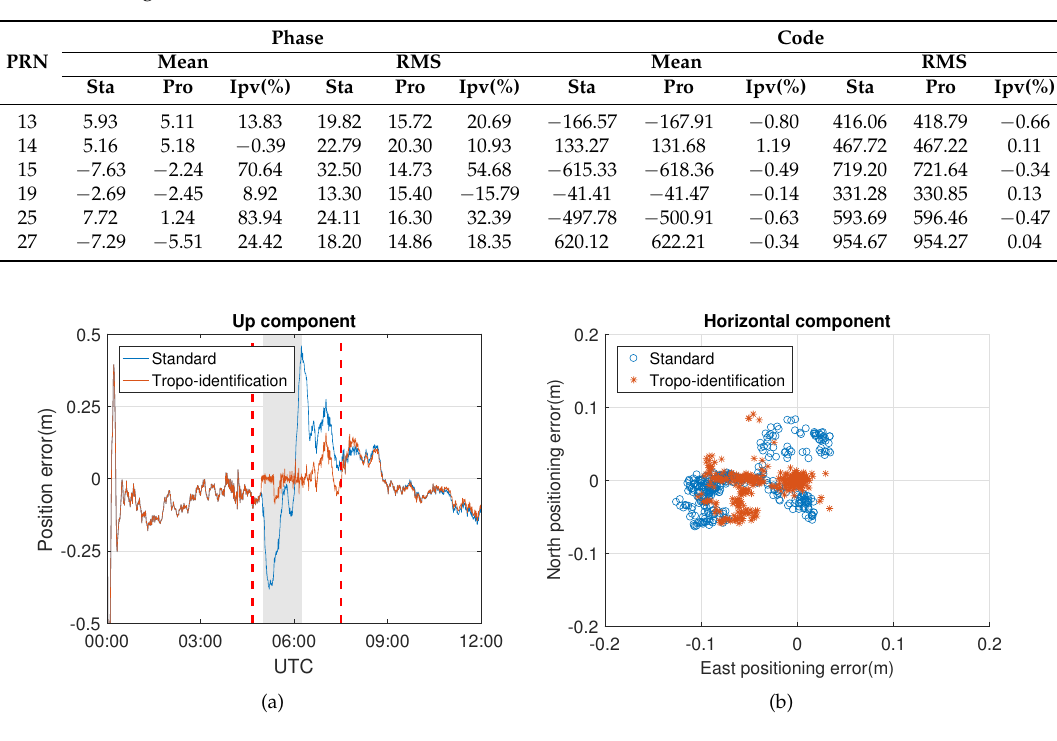
Figure 6. ( a ) Position errors of the up component and ( b ) the horizontal component of Event 1.